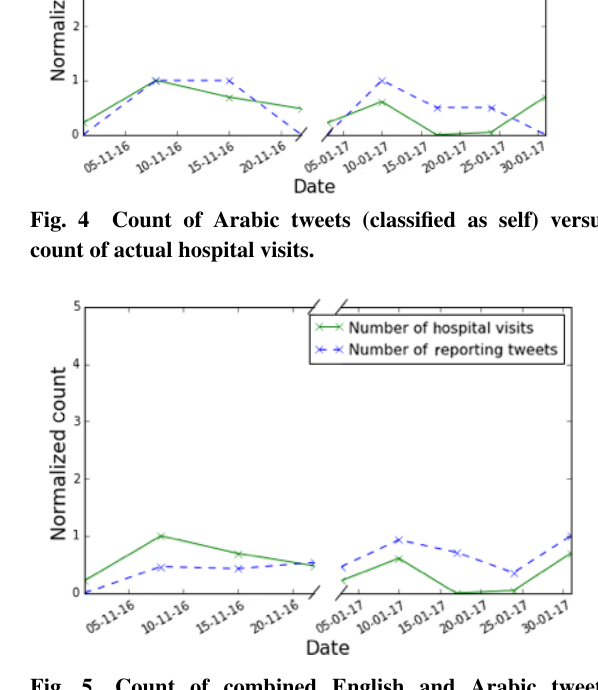
Fig. 5 Count of combined English and Arabic tweets (classified as self) versus count of actual hospital visits.